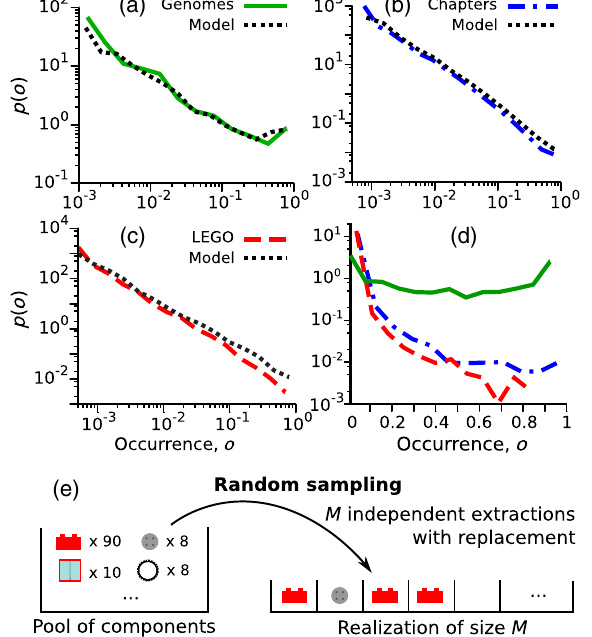
FIG. 3. The random-sampling model captures the main features of the empirical statistics of shared components. The plots show the normalized distribution p ð o Þ of component occurrences, quantifying the statistics of shared components for the three data sets: genomes (a), book chapters (b), and LEGO sets (c). The log-log scale highlights the power-law-like decay. The black dashed lines represent the prediction of the random-sampling model assuming the empirical component frequencies and realization sizes. The model reproduces very well the power- law decay, but may differ quantitatively from the empirical laws in the high-occurrence region. Panel (d) plots the same quantities in log-lin scale, to highlight the quantitative differences between systems and the presence or absence of a peak of core compo- nents. Note that the different range of the y -axis values with respect to previous panels is due to the different binning procedures, logarithmic vs linear. (e) Scheme of the random- sampling process: samples of size M are generated from independent draws from the “ universe ” of all possible compo- nents with their specific abundances. Therefore, the probability of a component extraction is proportional to its global abundance, i.e., the sum of its abundances over all realizations of the